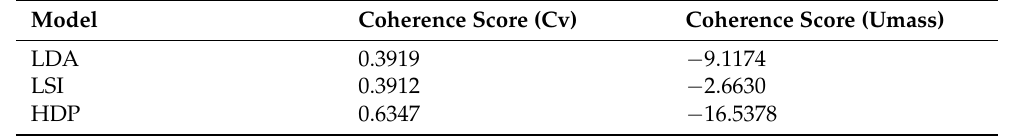
Table 3. Model coherence score.